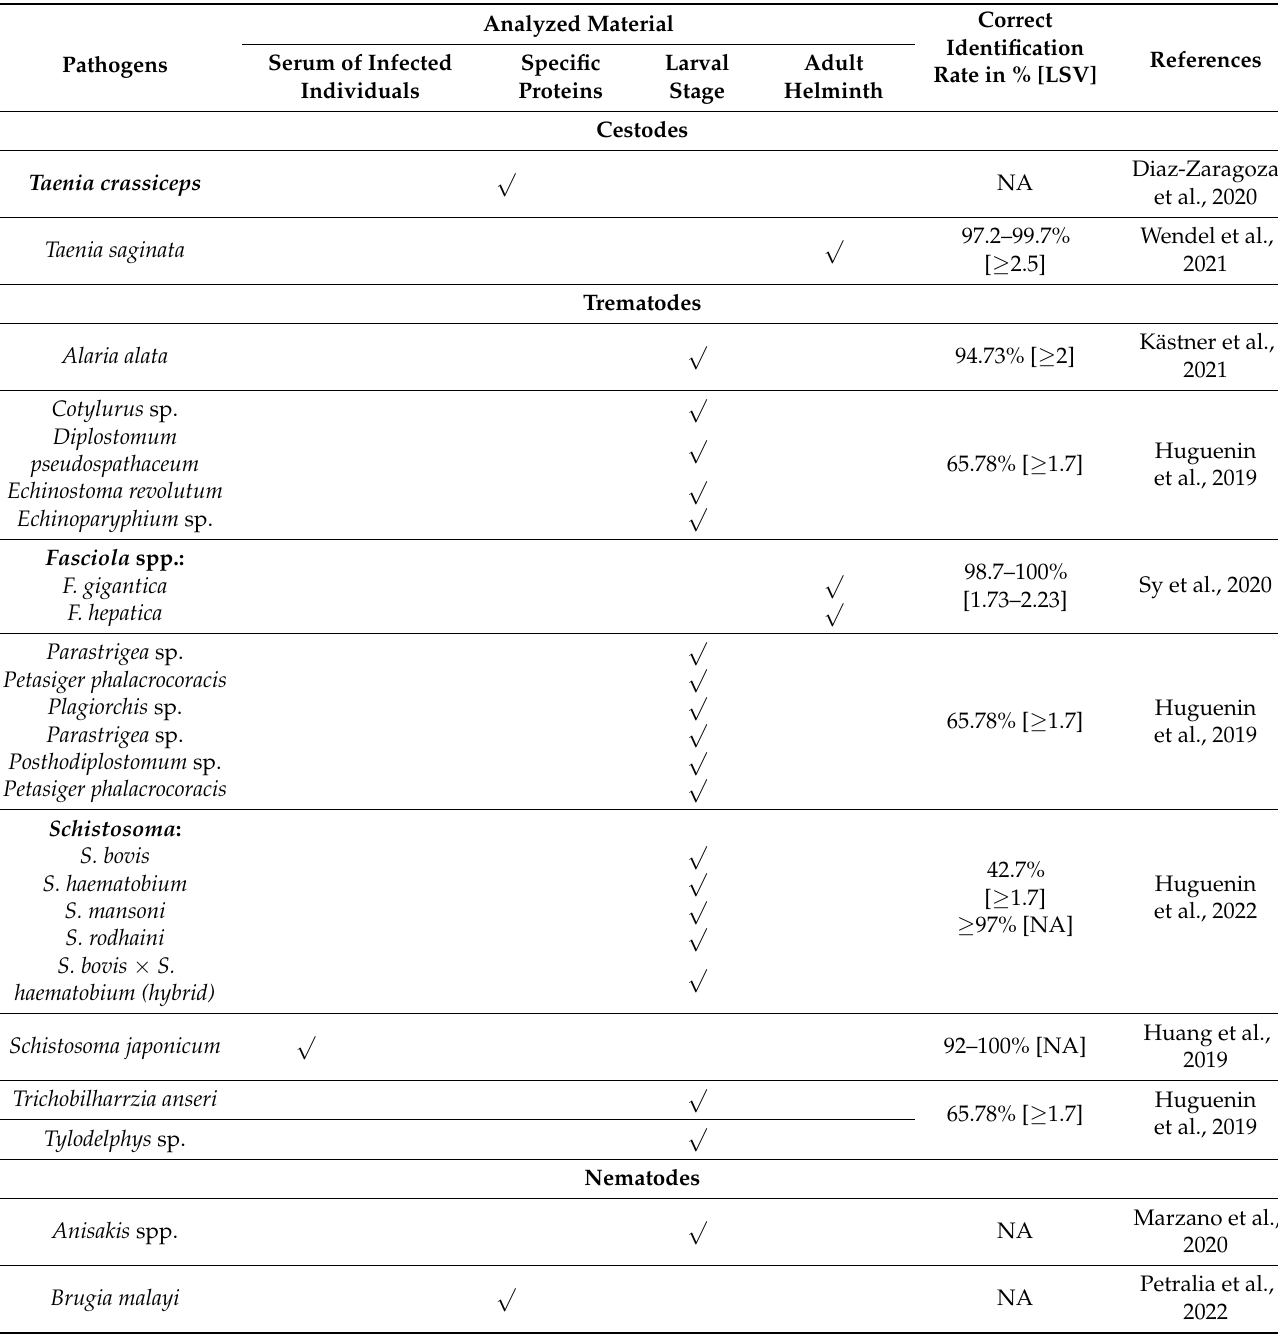
Table 1. Published studies pertaining to the application of MALDI-TOF MS on helminth samples between January 2019 to September